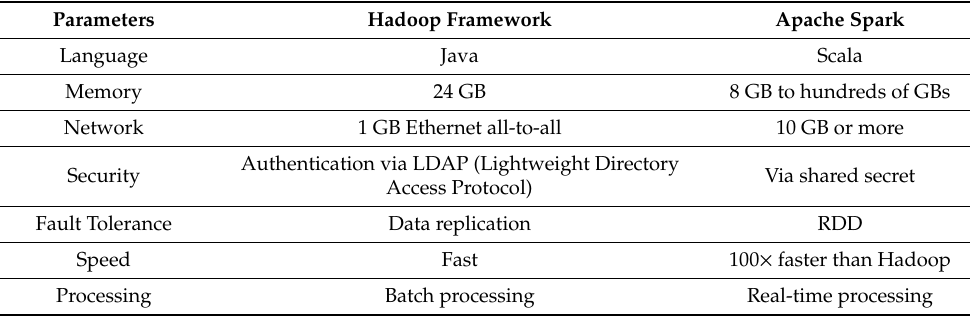
Table 12. Parameter comparison of Hadoop and Apache Spark. RDD—Resilient Distributed Datasets.